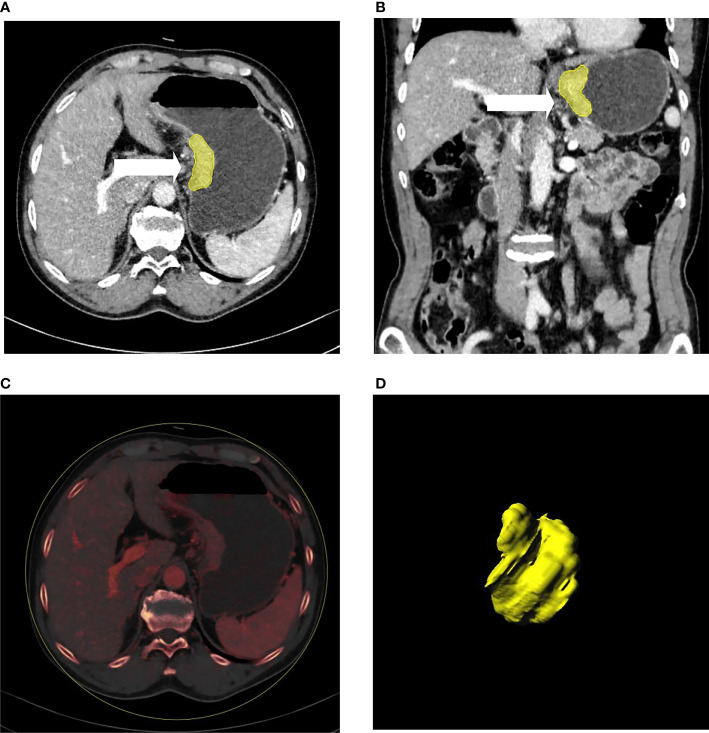
A patient with gastric cancer located in the cardia and lesser curve of the stomach (A–D). Axial (A) and coronal (B) multiplanar reconstruction from portal phase images showed abnormal enhancement accompanied by wall thickening of the stomach. The irregular outer layer of the gastric wall, blurring, and reticular strands surrounding the outer border (arrow heads) indicated that this patient was serosal invasion-positive, which was proven by histology. (C) showed the iodine map of the lesion. 3D reconstruction of the lesion is displayed (D).